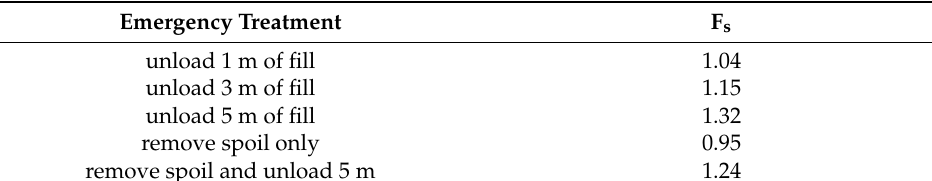
Table 6. Stability coefficient after taking emergency treatment measures.